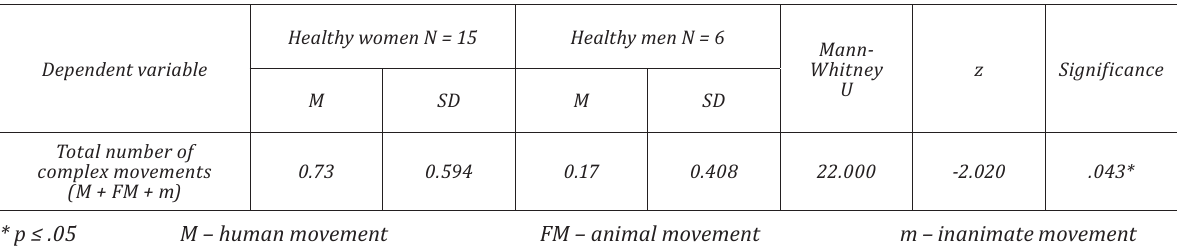
Table 5. Comparison of the group of healthy women with the group of healthy men in terms of the total number of complex movementss